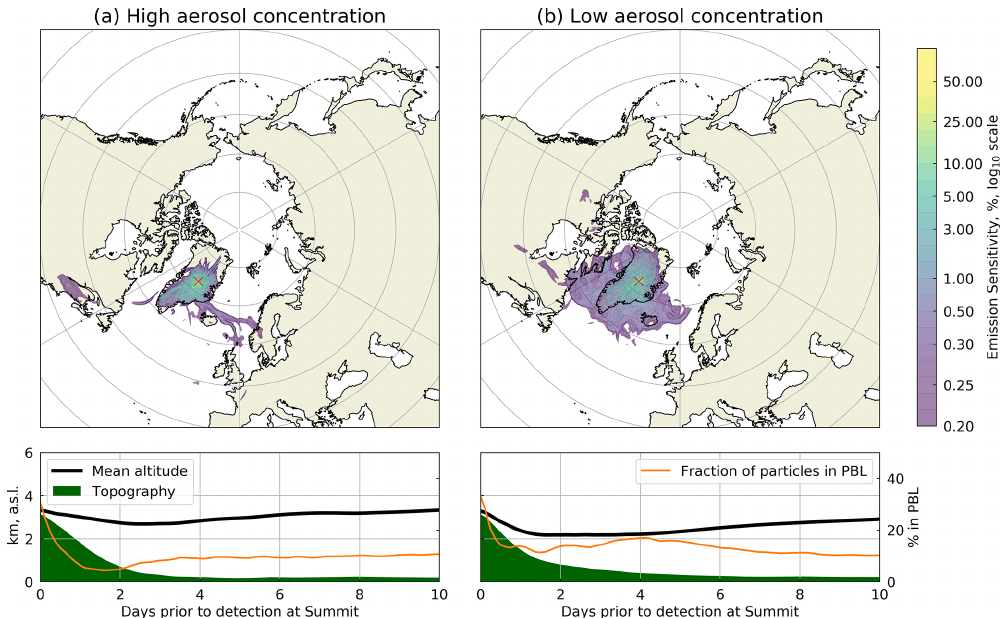
Figure 9. Results from FLEXPART back trajectory simulations averaged over the high- N 20 events (a) and the low- N 20 events (b) . Upper: surface emission sensitivity aggregated over 20d prior to detection at Summit (as a percentage of the maximum value). Lower: mean altitude and fraction of particles within the planetary boundary layer (PBL) for all simulated particles over the 10d prior to detection. tions fall below this threshold even more frequently.